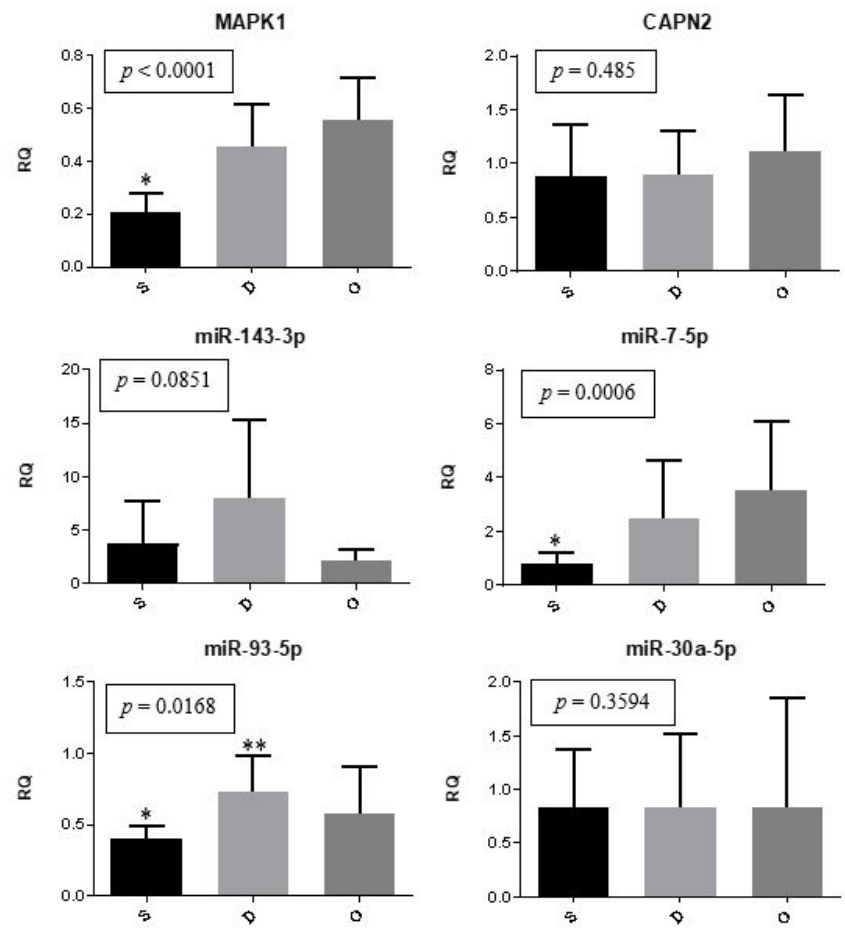
Figure 1. Ectopic implants. Representation of the mean ( ± standard error) gene and miRNA expression in superficial peritoneal endometriosis (S) ( n = 10), deep infiltrating endometriosis (D) ( n = 10), and ovarian endometrioma (O) ( n = 10). The groups highlighted with * and ** showed statistically significant differences in the Tukey post-hoc test. Gene and microRNA expression were compared between the control eutopic endometrium and the eutopic endometrium of women with endometriosis. The expression of miR-30a and miR-93 was significantly ( p = 0.0018 and p = 0.0052, respectively) upregulated in the eutopic endometrium of women with endometriosis compared to the controls. The expression of miR-143 was also statistically different between groups ( p = 0.0225); however, it was downregulated in patients with endometriosis. There was no significant difference regarding the expression of MAPK1 , CAPN2 , and miR-7 (Figure 2).